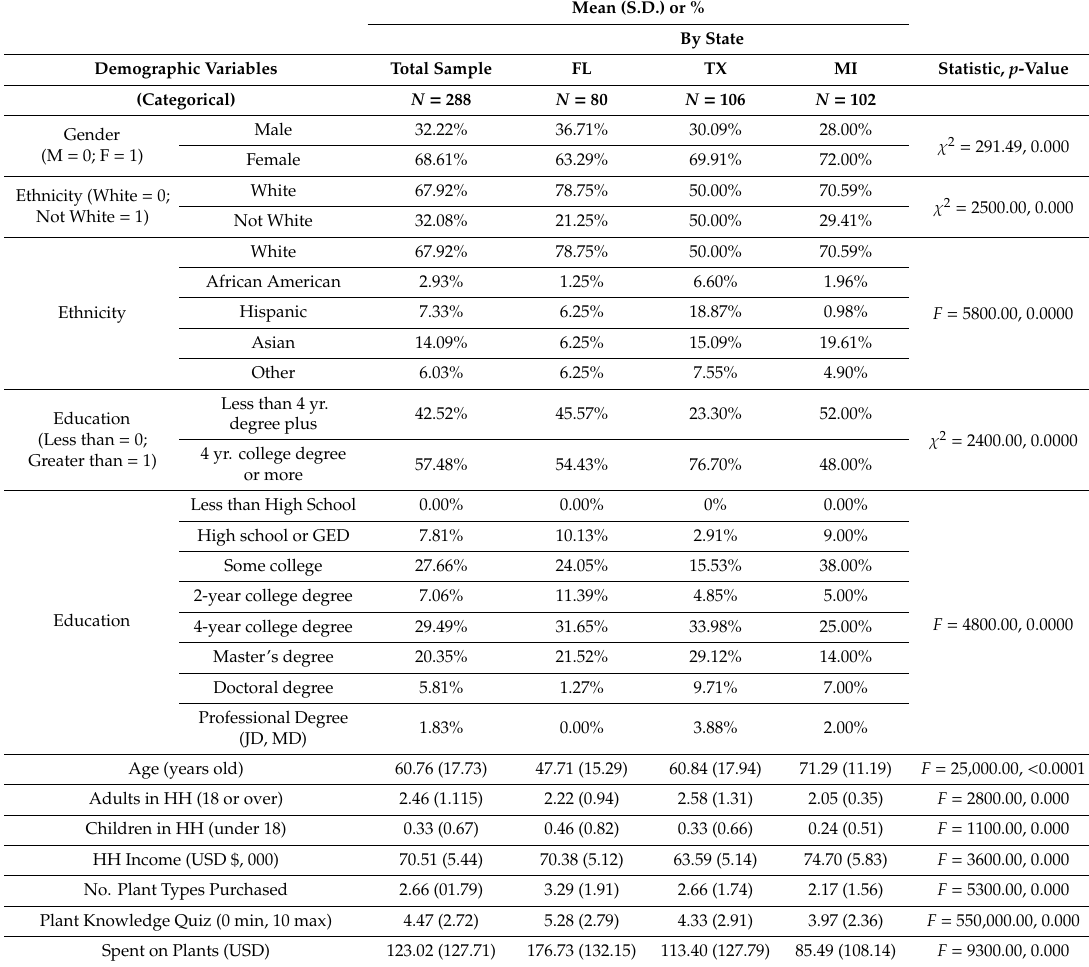
Table 2. Demographic variables of overall sample and by state (Florida, Texas, and Michigan) 1